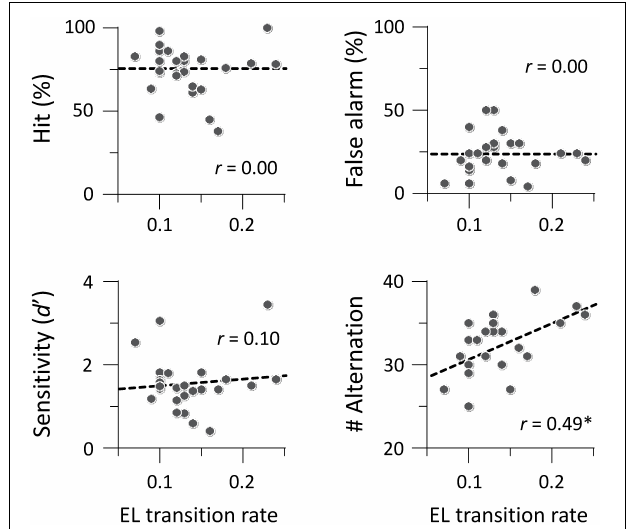
FIGURE 5 | Brain-behavior relationship between transition rate and task performance ( N = 26). The number of alternations between in- and out-of-the-zone periods was correlated with the transition rate between local minima 1 and 4 in energy landscape (EL) analysis. * p < 0.05 (Bonferroni correction for multiple comparisons).